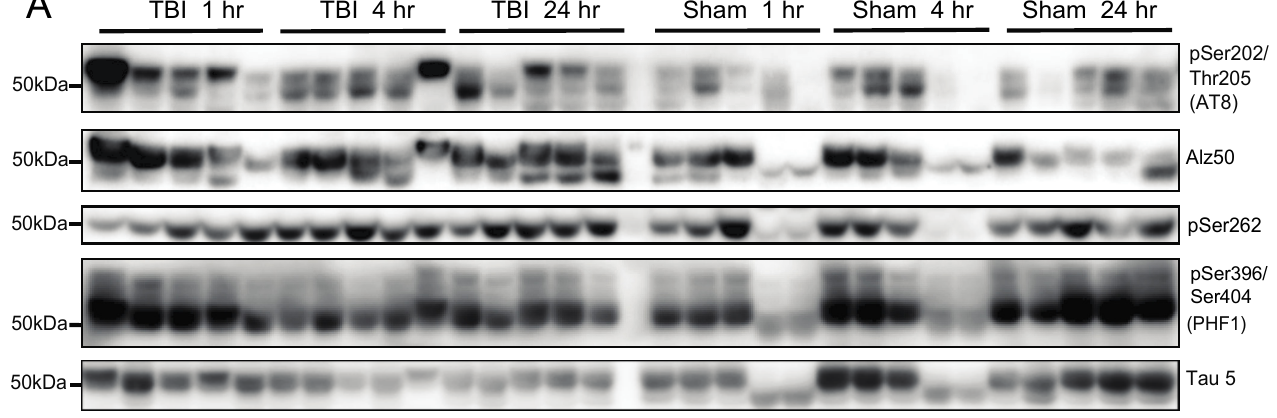
Figure 1. A single blast overpressure (BOP) caused increased tau phosphorylation in the mouse brain. ( A ) Representative Western blots demonstrated the early elevation of phospho-tau (Ser202/Thr205 detected by AT8, pS262, and Ser396/Ser404 detected by PHF1 antibody and pathological conformation changes of tau (Alz50) in the cortex after blast ( n = 5/group). Tau-5 was probed to detect total tau. ( B – E ) Quantification analysis of AT8 ( B ), Alz50 ( C ), pS262 ( D ), and PHF1 ( E ) nor- malized to total tau detected b they tau 5 antibody. (Data are means ± SEM, * p < 0.05, ** p < 0.01; ns, non-significant). TBI: traumatic brain injury.